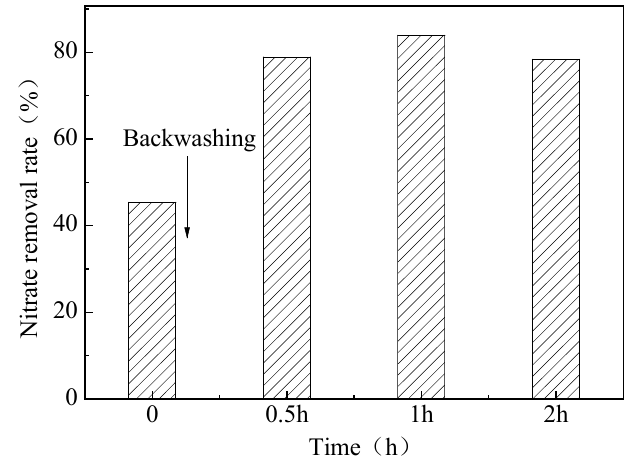
Figure 12. Backflush recovery of pilot-scale bioreactor.